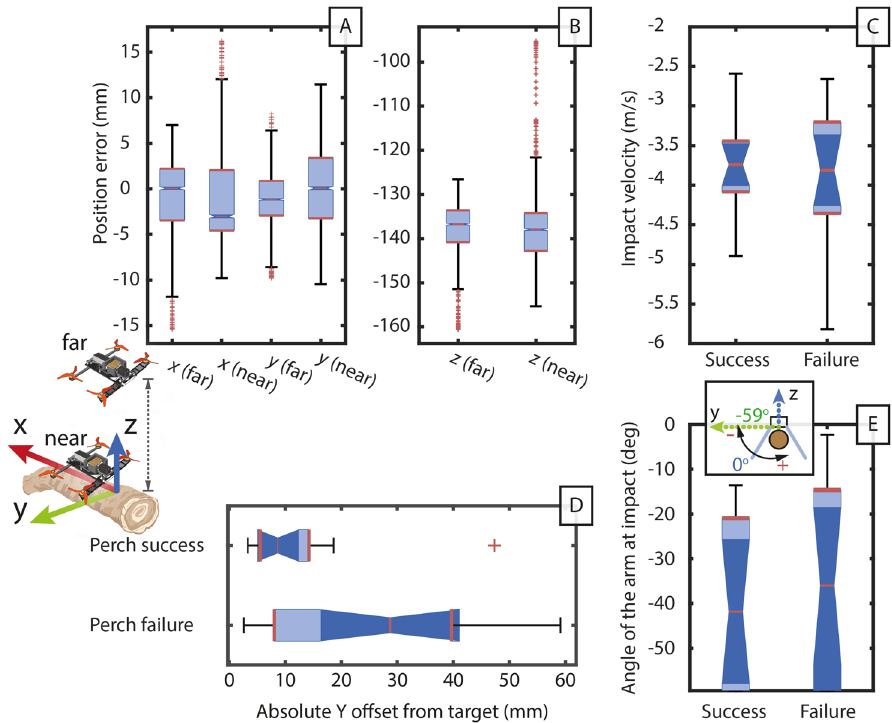
Figure 5. Statistical analysis of the test data. ( A ) Position errors of the robot flying unobstructed and ( B ) near the artificial branch, approximately 1.5 m and 0.5 m above the branch, respectively. ( C ) Statistical correlation between perching success/failure and the impact velocity. ( D ) Correlation between perching success/failure and the absolute Y offset from the branch at impact. ( E ) Statistical analysis of the drop-perch